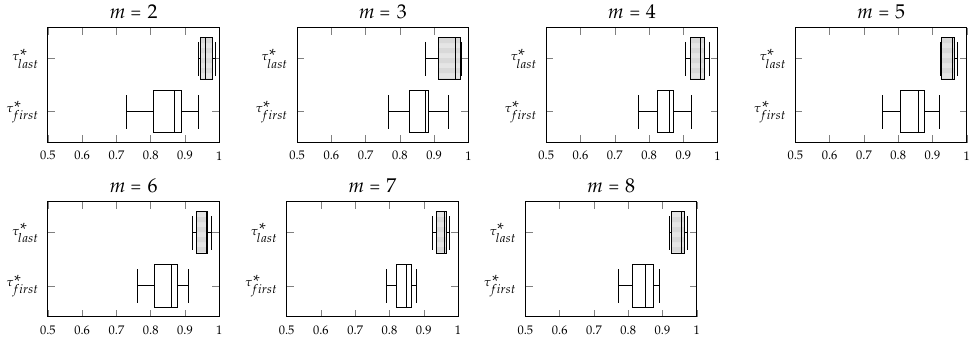
Figure 5. Variation of the concordance indices τ ∗ of experts m (Category